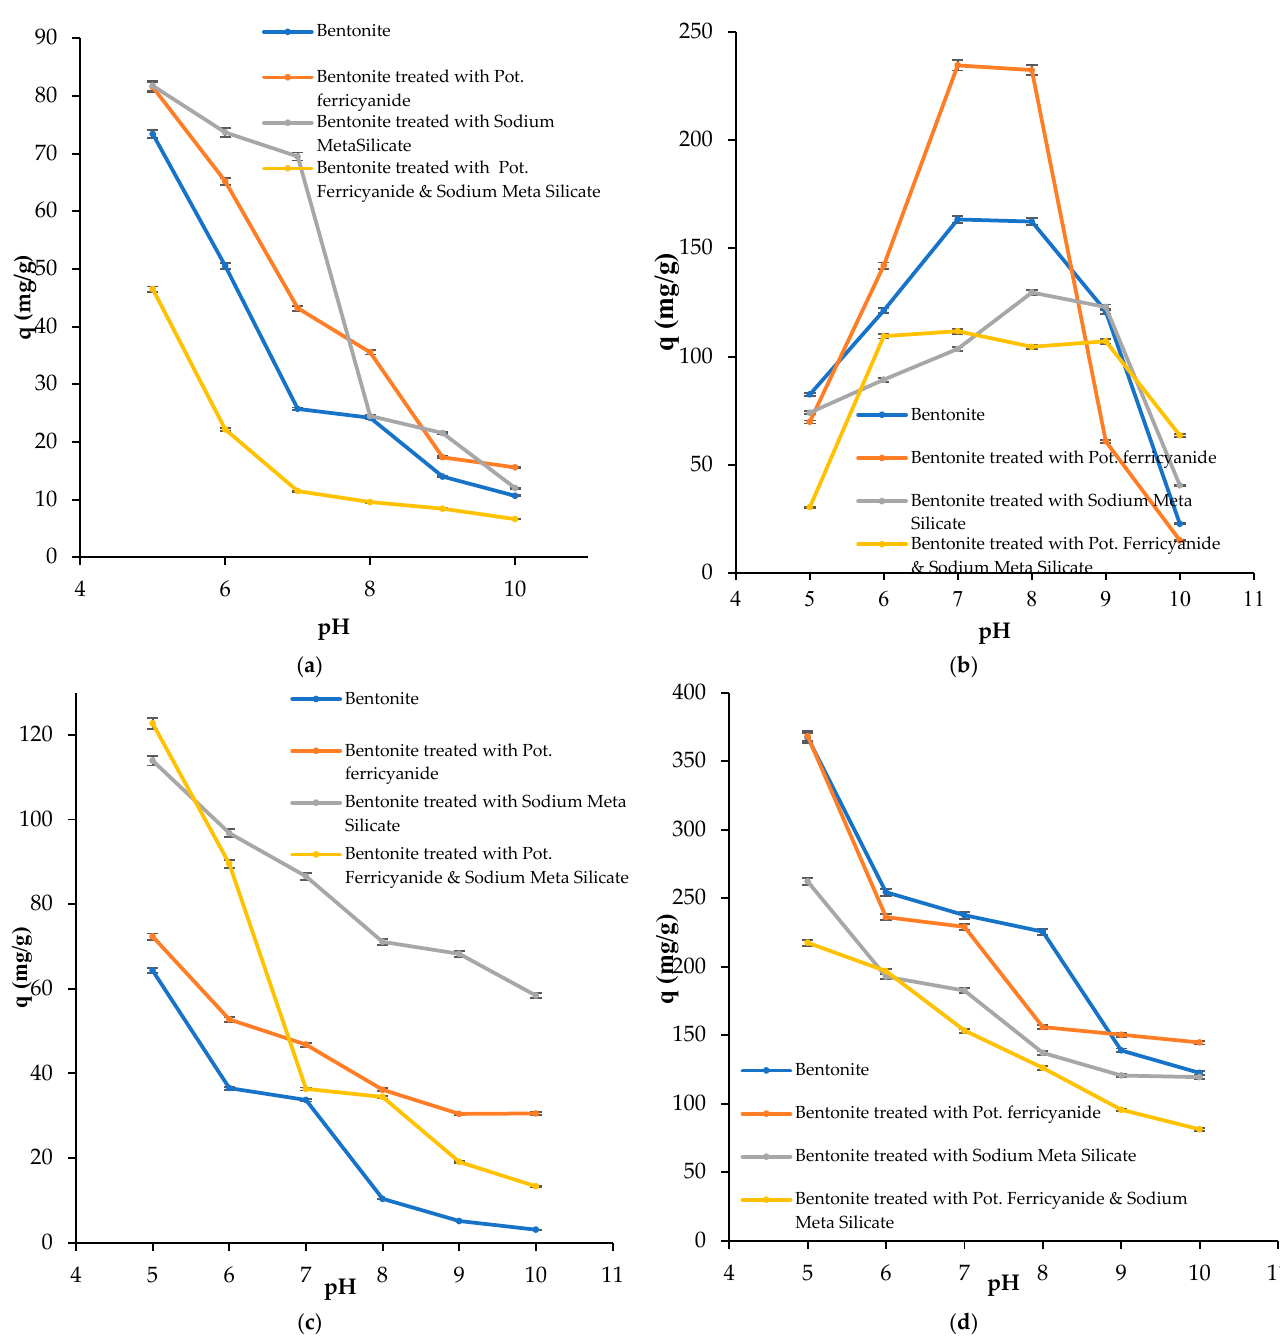
Figure 6. Adsorption capacities of adsorbents for ( a ) Acid red, ( b ) Direct violet-51, ( c ) Reactive red, and ( d ) Reactive green-5 dyes at varied pH.